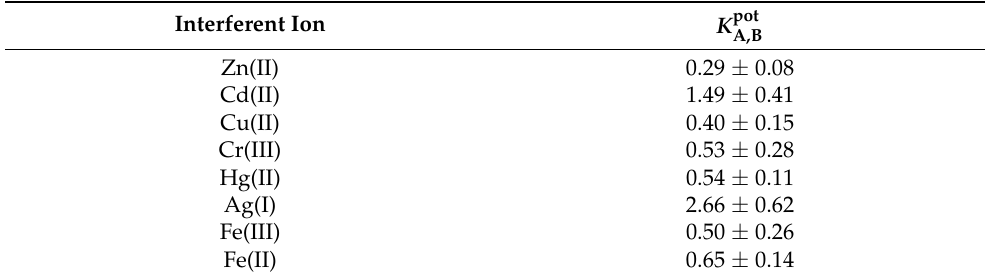
Figure 9. Slopes of the electrode function of the LS-based PU sensor doped with 1% w / w MWCNTs at pH 2 (mean values of at least three calibrations with their respective standard deviations). Table 1. Selectivity coefficients, K pot , of the LS-based sensor towards Cr(VI), determined using the A,B matched potential method (mean values of at least three